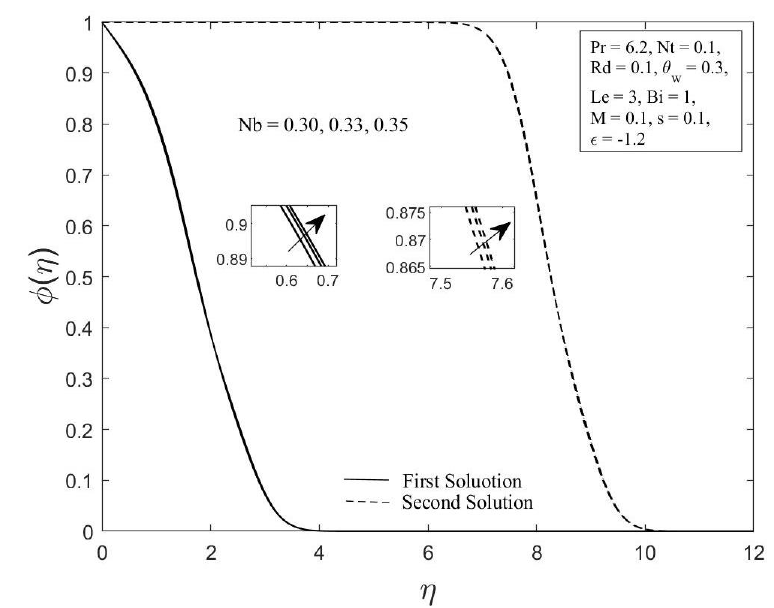
Figure 7. The concentration profile 𝜑(𝜂) for diverse values of 𝑁𝑏 .